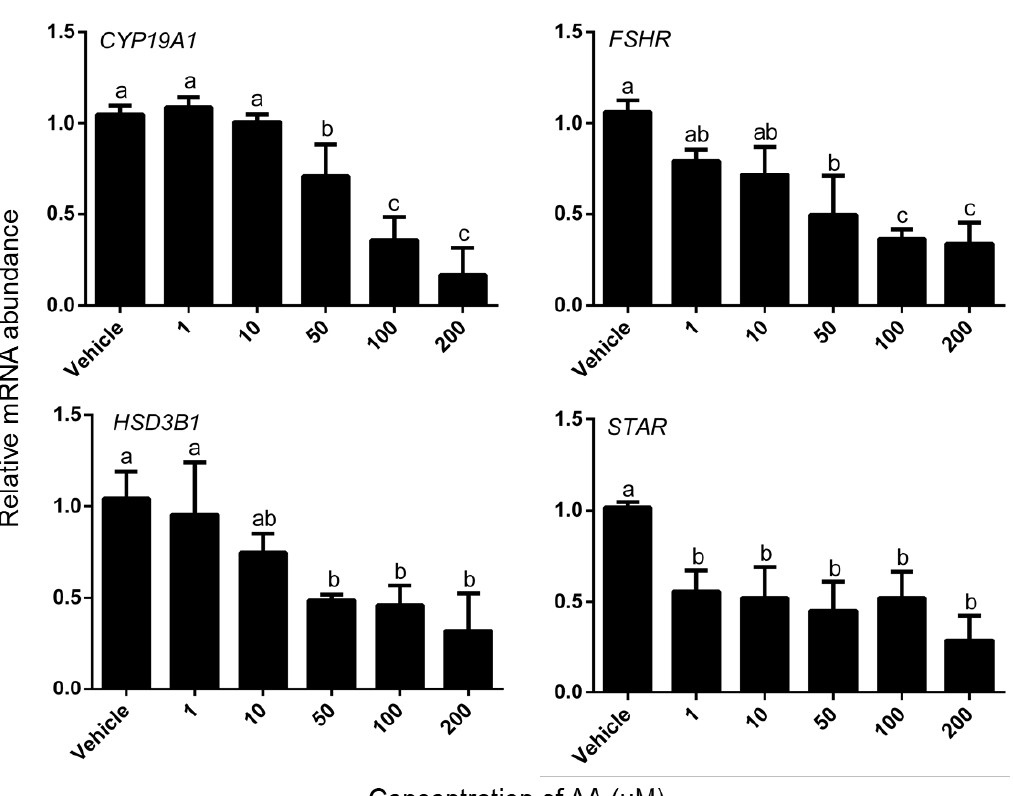
Figure 5. Effects of AA on the mRNA abundance of the related steroidogenic genes in granulosa cells. Granulosa cells were challenged on Day 3 of culture with the doses given of AA for 24 h. Data are means ± SEM. of three independent replicates. For each treatment, means without common letters are significantly different ( p < 0.05).